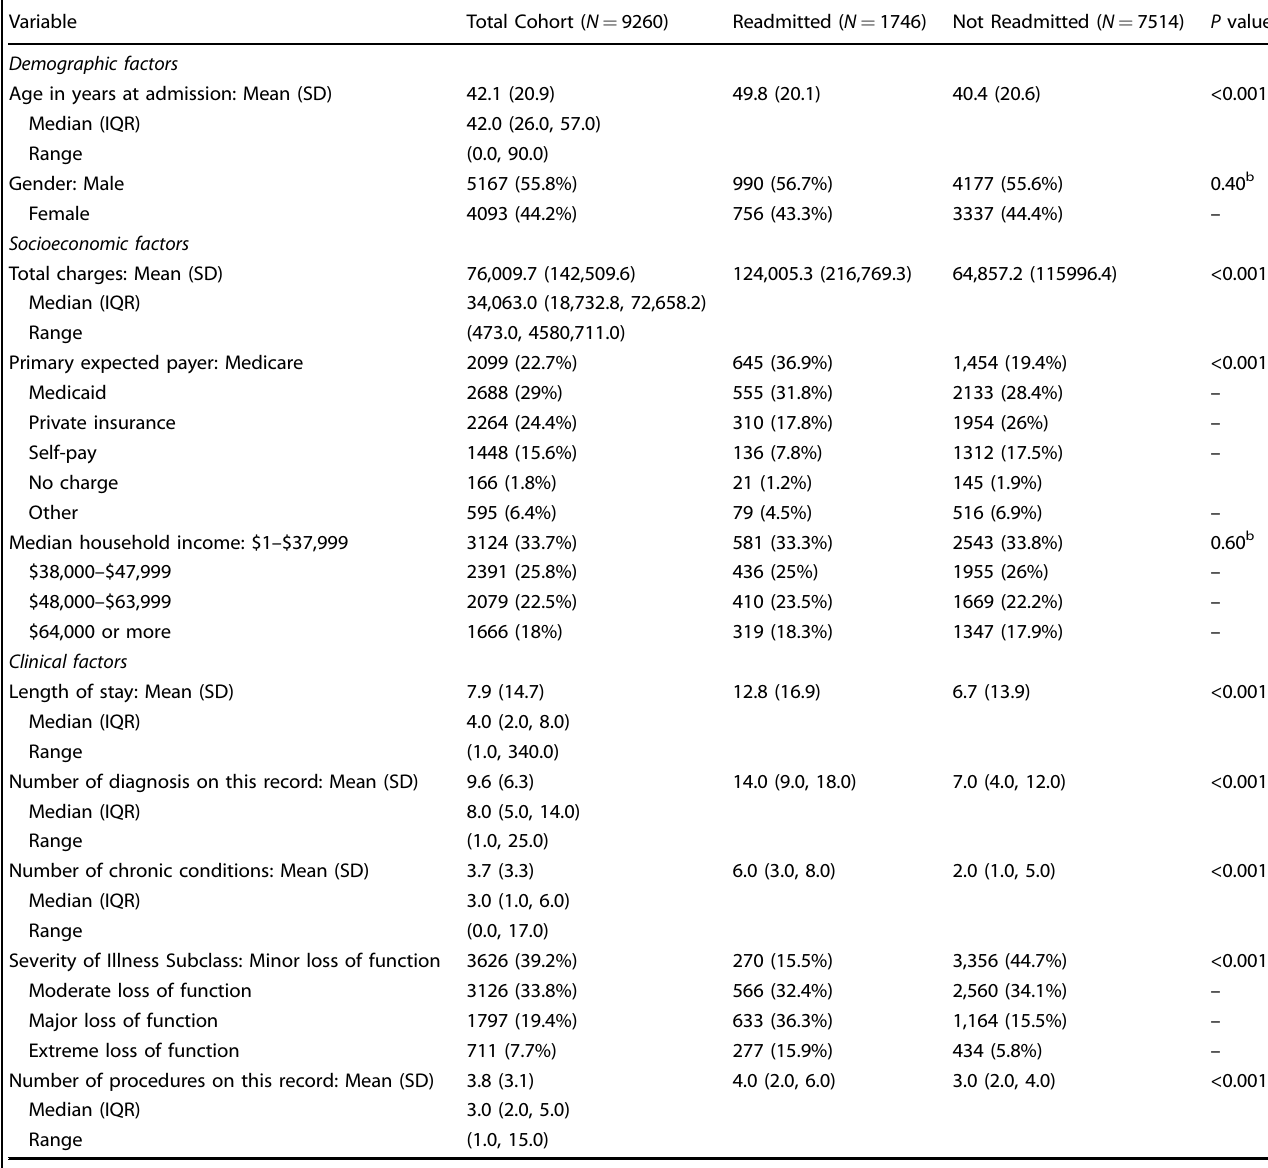
Table 1. Descriptive summary of the 90-day dental hospital readmission